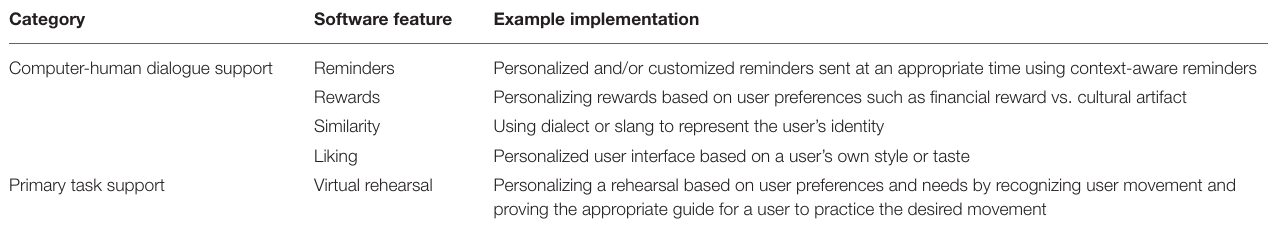
TABLE 2 | Example of true personalized persuasive software features.